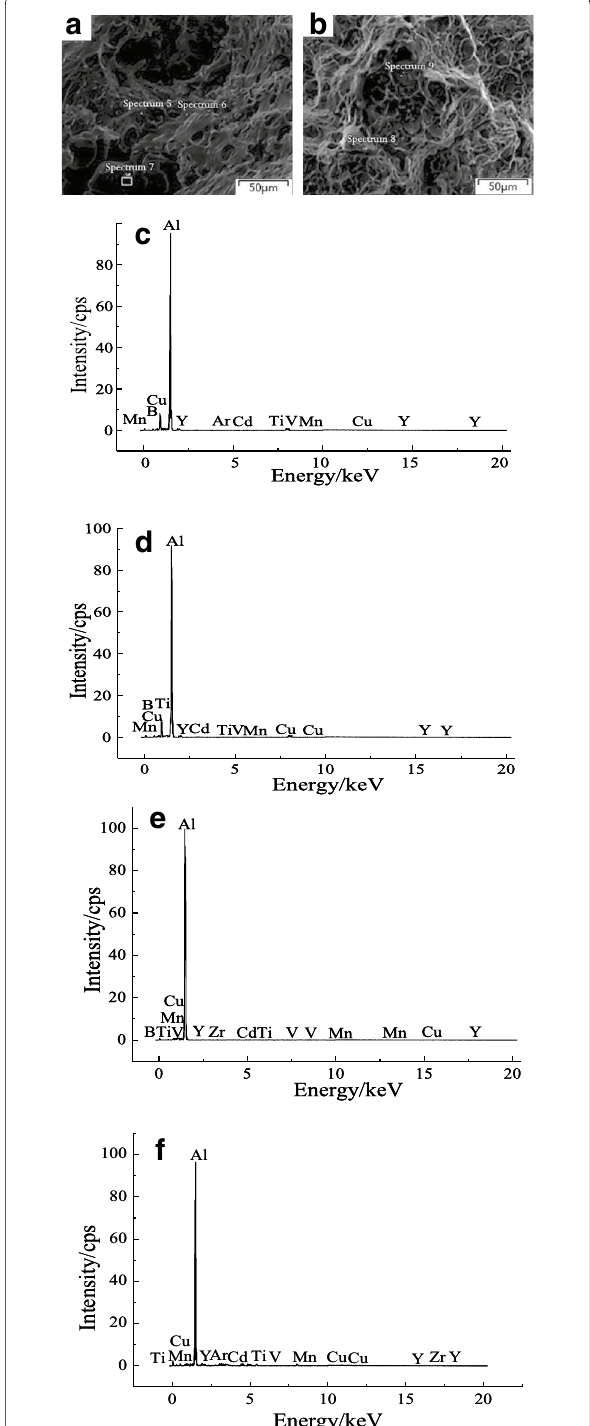
Figure 8 a , b Images of alloys, c – f local EDS images of the studied